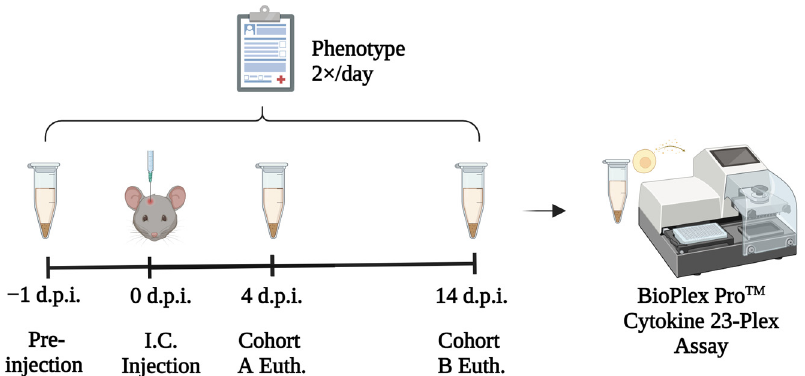
Figure 1. Schematic of experimental design used for this study. “Euth: Euthanasia”.